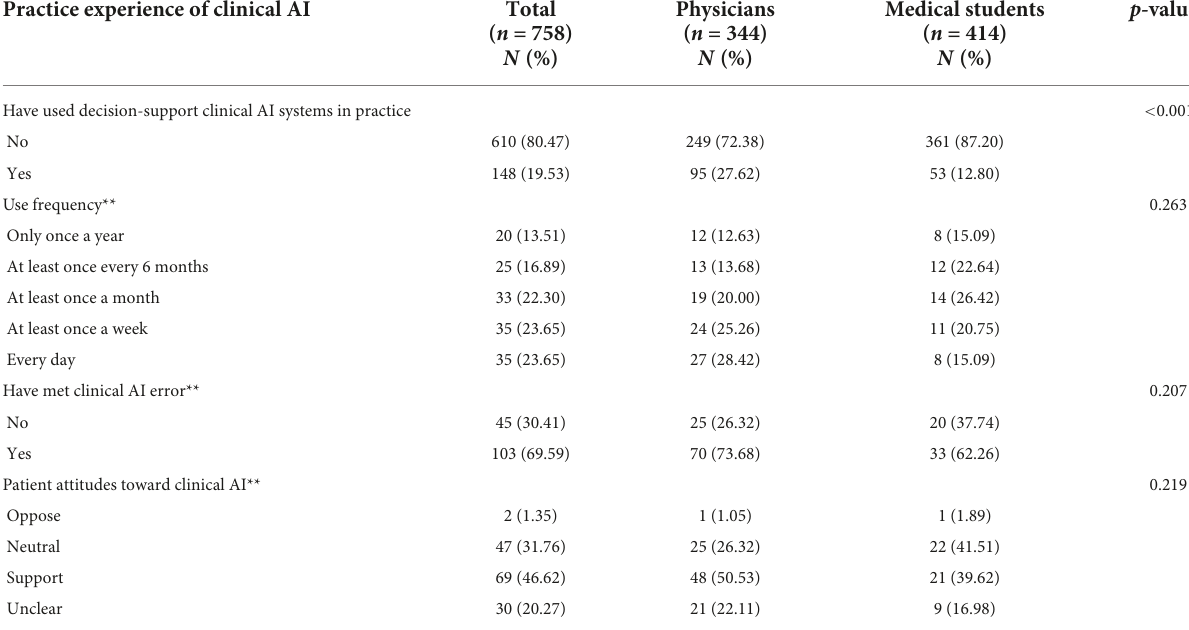
TABLE 3 Respondent practical experience of clinical artificial intelligence (AI) over the past